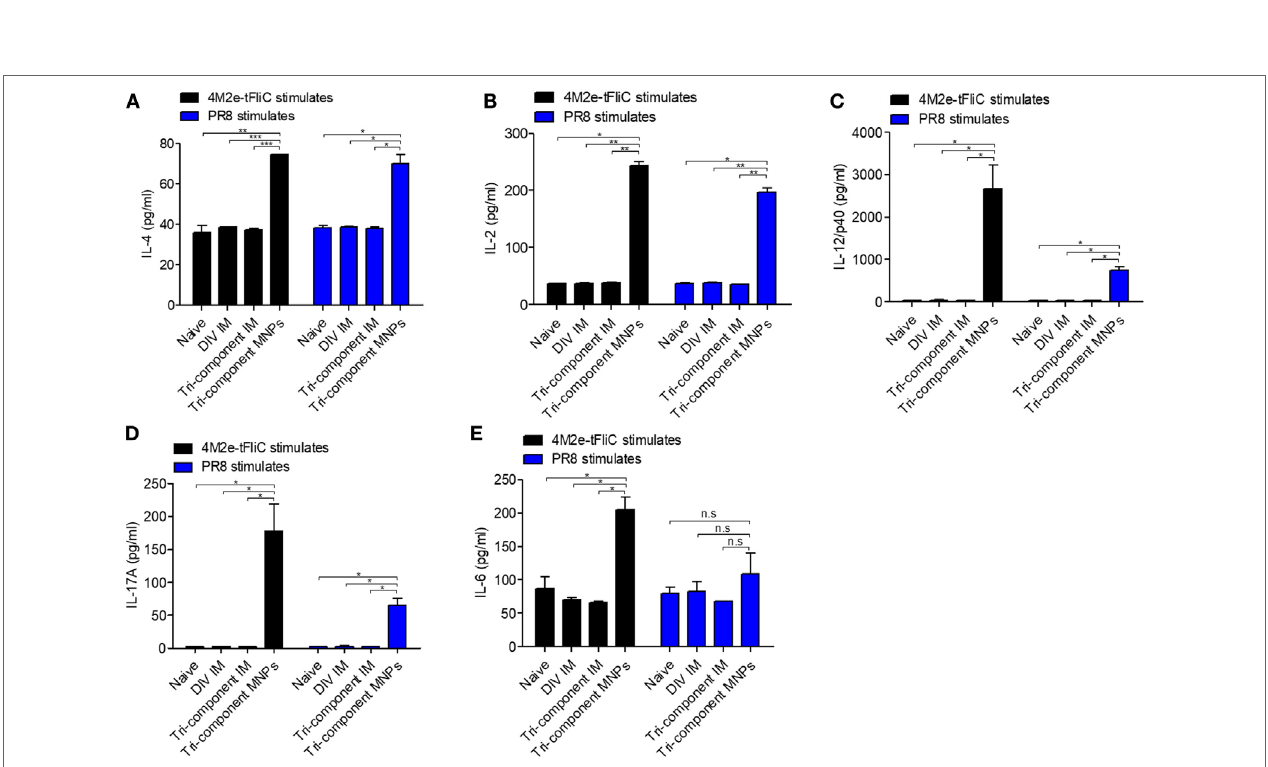
FigUre 4 | Induction of cytokine secretion in vitro . Single-cell suspensions from inguinal lymph nodes ( N = 3) were stimulated with 4M2e-tFliC fusion protein or PR8-inactivated virus in vitro for 5 days. The cytokines in supernatants were determined by cytokine ELISA. (a) IL2; (B) IL-4; (c) IL-12/P40; (D) IL-17; (e) IL-6. Data represent mean ± SEM. The statistical significance was analyzed by Student’s t -test. * p < 0.05, ** p < 0.01, *** p < 0.001, n.s p > 0.05.